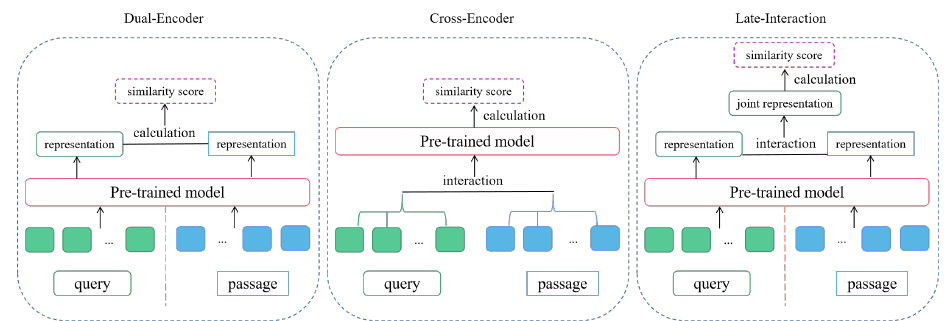
Figure 1. Retriever Methods. Among the methods, dual-encoder is more efficient, cross-encoder is more accurate, and late-interaction looks for a balance of efficiency and